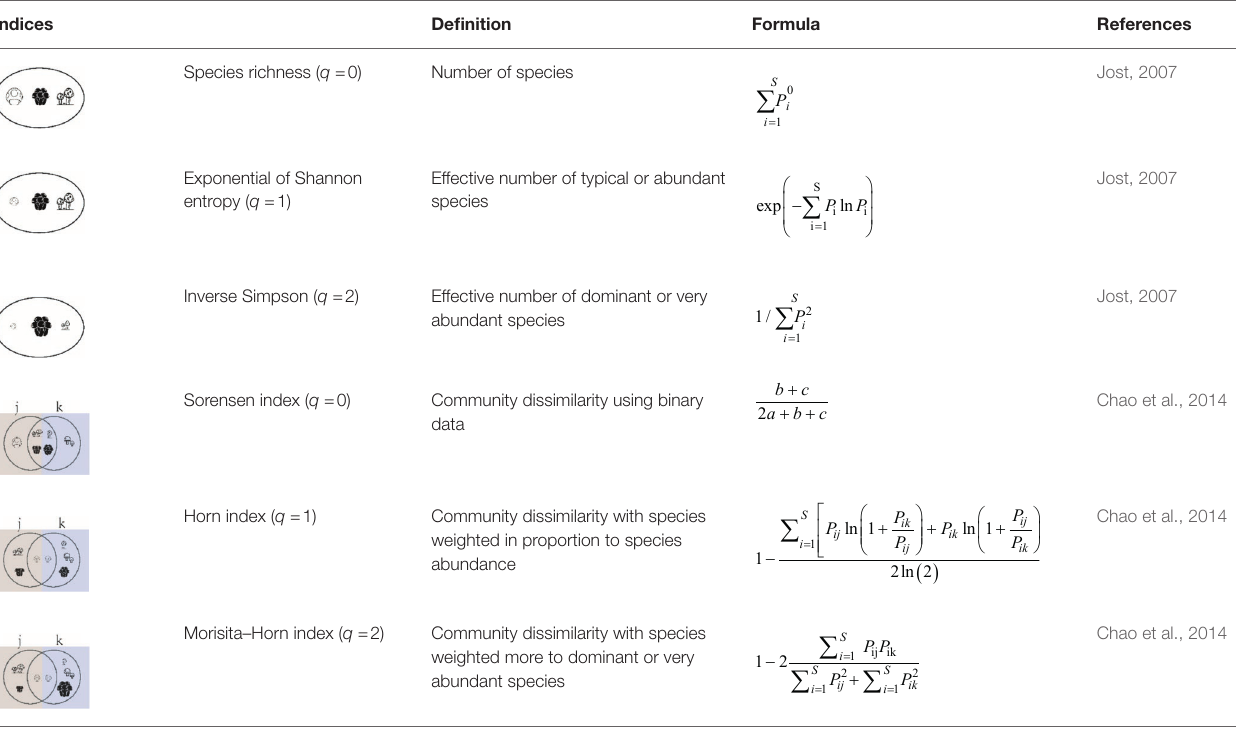
TABLE 1 | Summary of alpha and beta diversity indices used in this